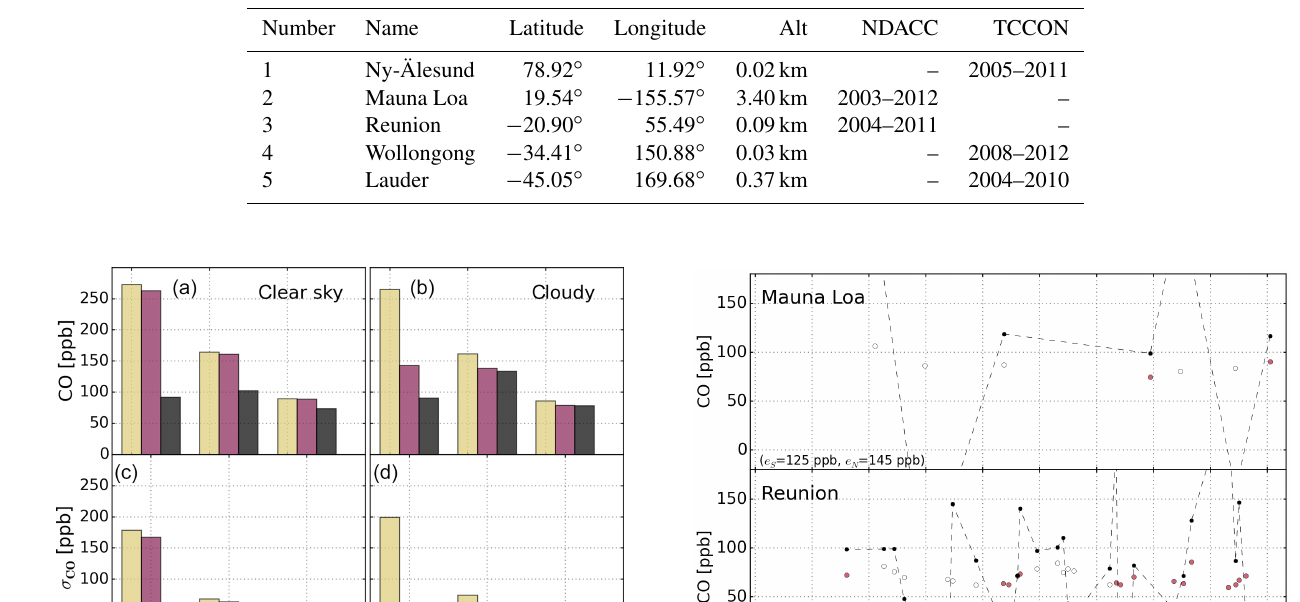
Table 2. Same as Table 1, but for NDACC and TCCON sites.